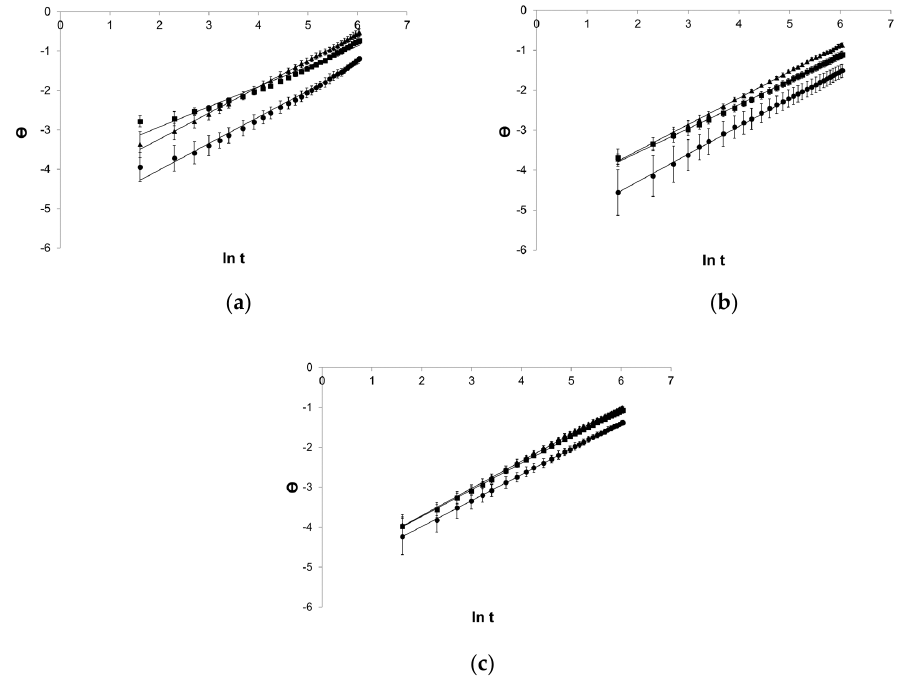
Figure 6. Process of release kinetics of β E performance according to the Weibull model; ( a ) MC gel formulations, ( b ) PA1 gel formulations, ( c ) gel formulations with PC-11, Θ —ln[ − ln(1 − (released percent / 100%))], (cid:78) —reference gel, (cid:4) —20% of MSA, (cid:8) —40% of MSA, n =